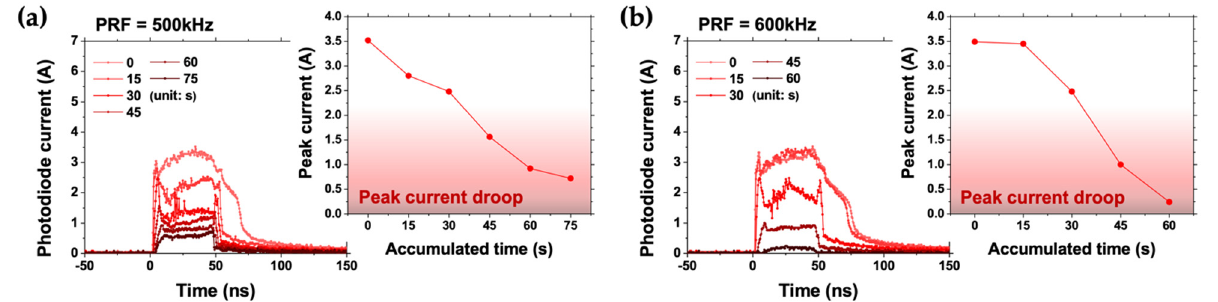
Figure 6. Reliability test for the integrated system and the corresponding photodiode responses from the employed PCSEL operated with a fixed pulse width of 50 ns. ( a ) Sequence of photodiode responses from the PCSEL operated at 500 kHz for comparison. Inset: Corresponding peak currents extracted from ( a ). Due to the self-heating effect, heat will accumulate over time. Thus, an obvious output droop can be observed and the corresponding peak current drops from 3.52 A to 0.72 A within 75 s. ( b ) A sequence of photodiode responses from the PCSEL operated at 600 kHz for comparison. Inset: Corresponding peak currents extracted from ( b ). Herein, the corresponding peak current rapidly drops from 3.49 A to 0.24 A within just 60 s due to a higher pulse repetition frequency.